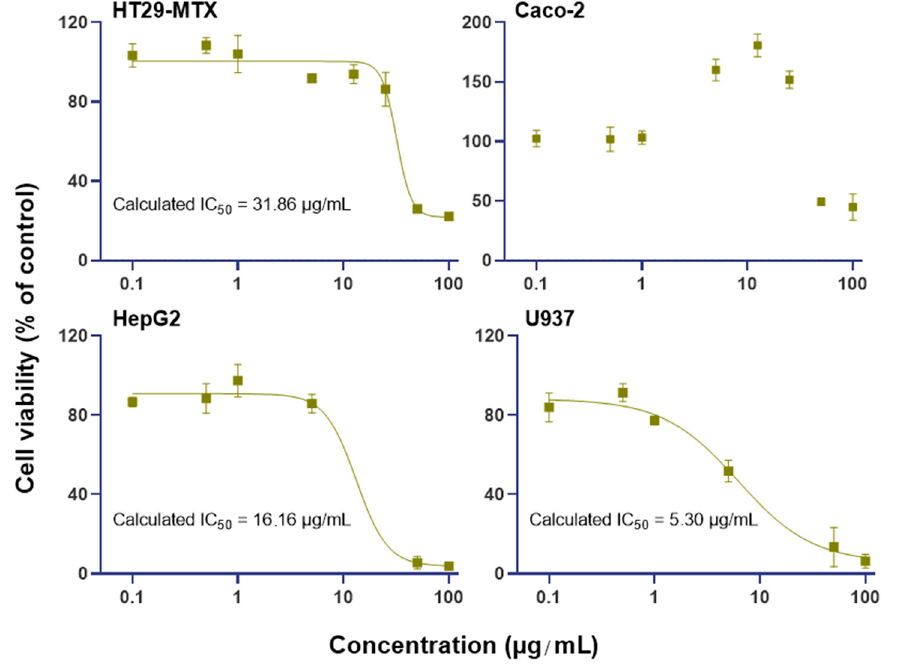
Figure 9. Effect of BrCl-flav on the viability of four human cell lines. Cells were incubated for 24 h with the BrCl-flav at increasing concentrations (0.1 to 100 µg/mL). The viability of the cells was evaluated by the measurement of mitochondrial hydrogenase activity assayed with CCK8 reagent. Means are presented ± SD (N = 2, n = 6). The molecule concentration required to cause 50% inhibition of the cell viability (IC 50 ) was determined using the nonlinear regression analysis function of GraphPad Prism.